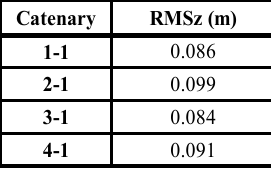
Table 7. RMS of z-residuals of Model